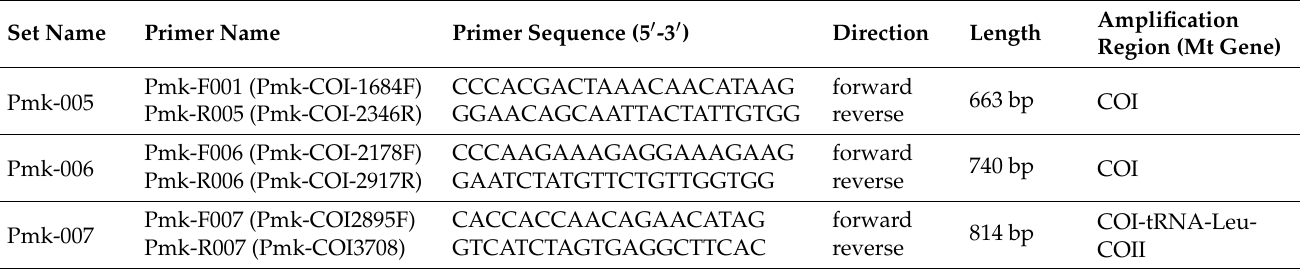
Table 3. Primers used in this